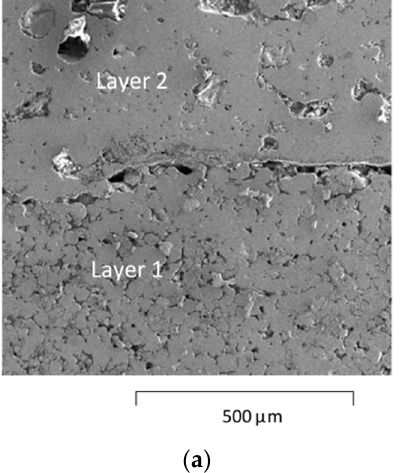
Figure 9. Layer bonding quality: ( a ) A SEM image of the layered structure, with an imperfect bonding between two layers. ( b ) The absorbed microwave power vs. the total LMH–AM process duration required for a proper bonding of the melted powder layer to the underlying previously solidified layers (the full and empty dots indicate proper and improper bonding results, respectively). The energy density (in J/mm 3 ) is marked by the dashed